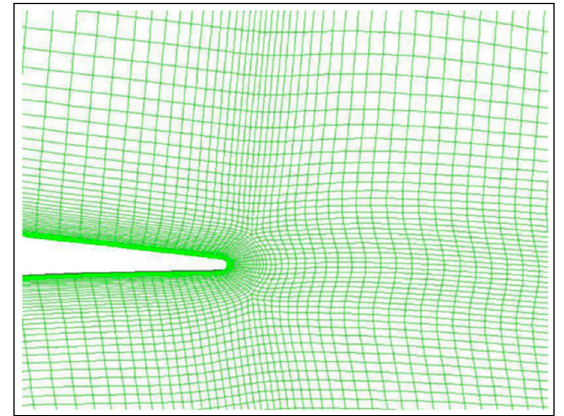
Figure 21. Grid refinement near the primary nozzle trailing edge [165].